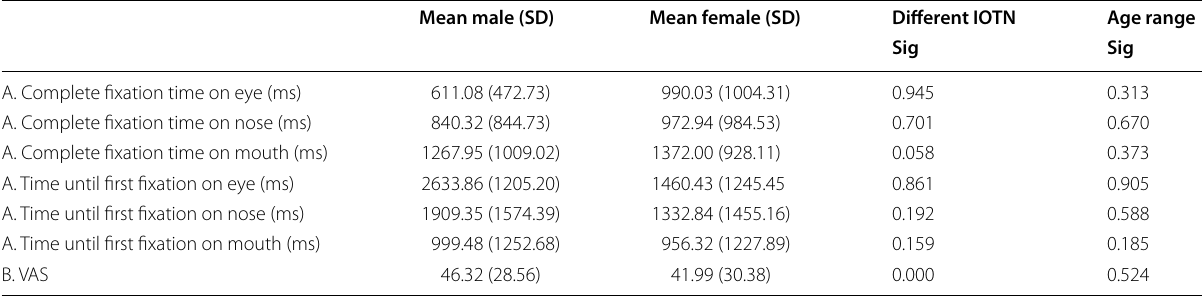
Statistical difference p <